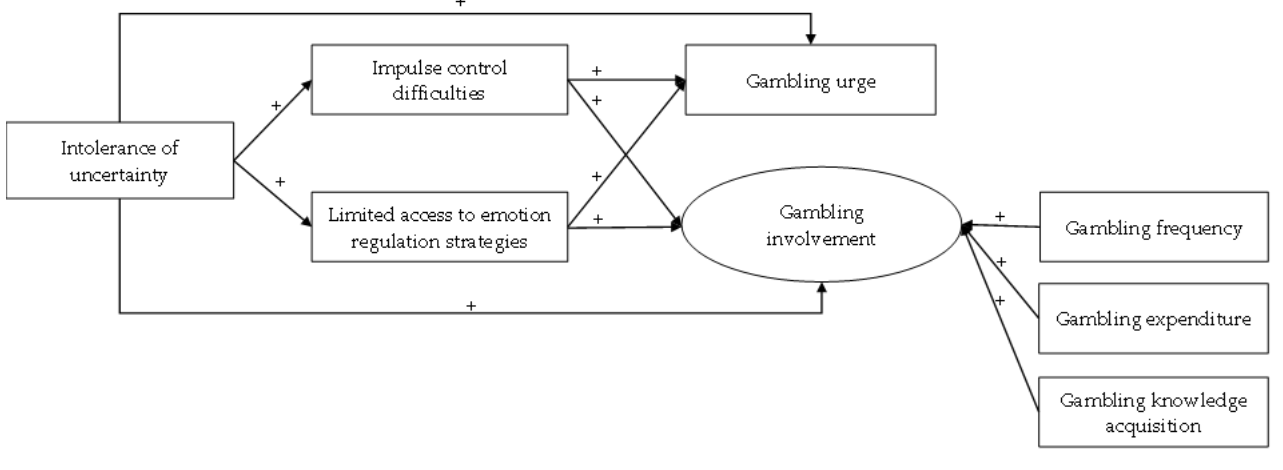
Figure 1. The hypothesized path model.